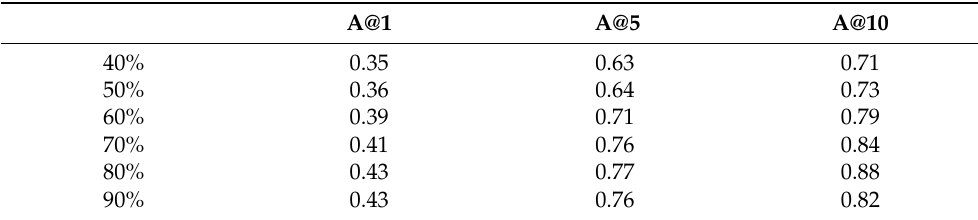
Table 4. The effectiveness of CodeHunter with different sizes of the training set.